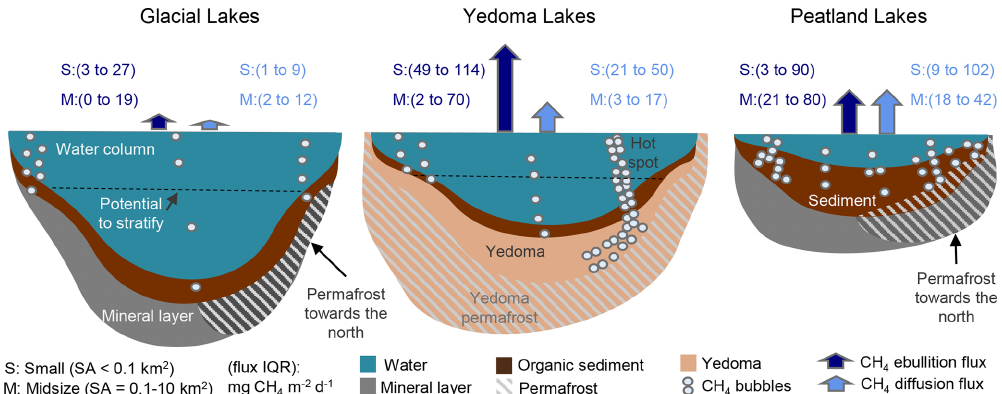
Figure 4. Conceptual diagram of the aquatic land cover classes. Key differences between the three overarching lake genesis “types” and their CH 4 -emitting characteristics are shown, including sediment type, permafrost conditions, and water column depth. Fluxes (interquartile ranges, IQRs) for each class size within the overarching types are shown above the lakes for both diffusive and ebullitive transport pathways. Arrows are scaled based on mean flux values. See Sect. 3.3 for a detailed breakdown of aquatic fluxes. Large Lakes are not